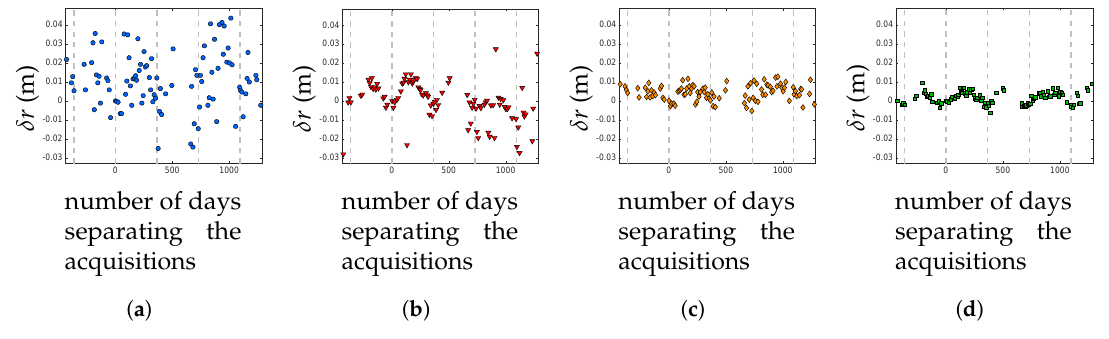
Figure 6. Measured deformation given the number of days separating the acquisitions. ( a ) • Eiffel Tower; ( b ) (cid:72) Cristal Tower; ( c ) (cid:7) Keller Tower; ( d ) (cid:4) Mirabeau Tower. The vertical dashed lines represent the years from the master image acquired the 24 January